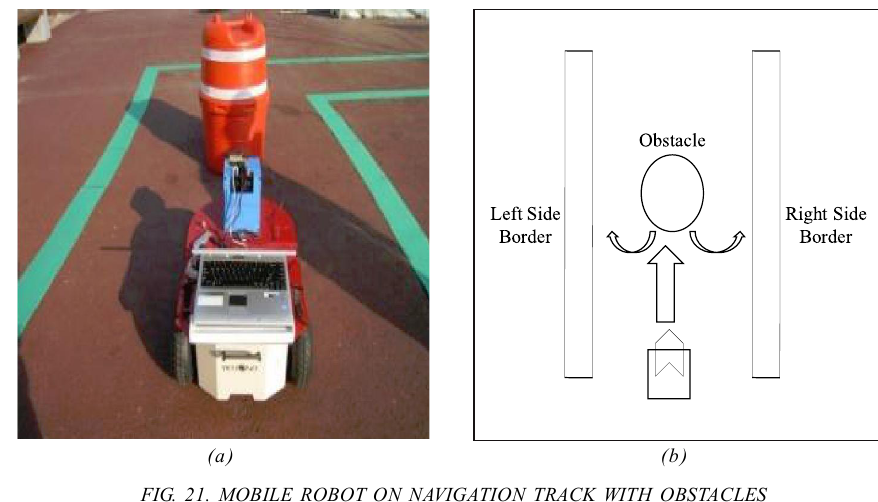
FIG. 21. MOBILE ROBOT ON NAVIGATION TRACK WITH OBSTACLES